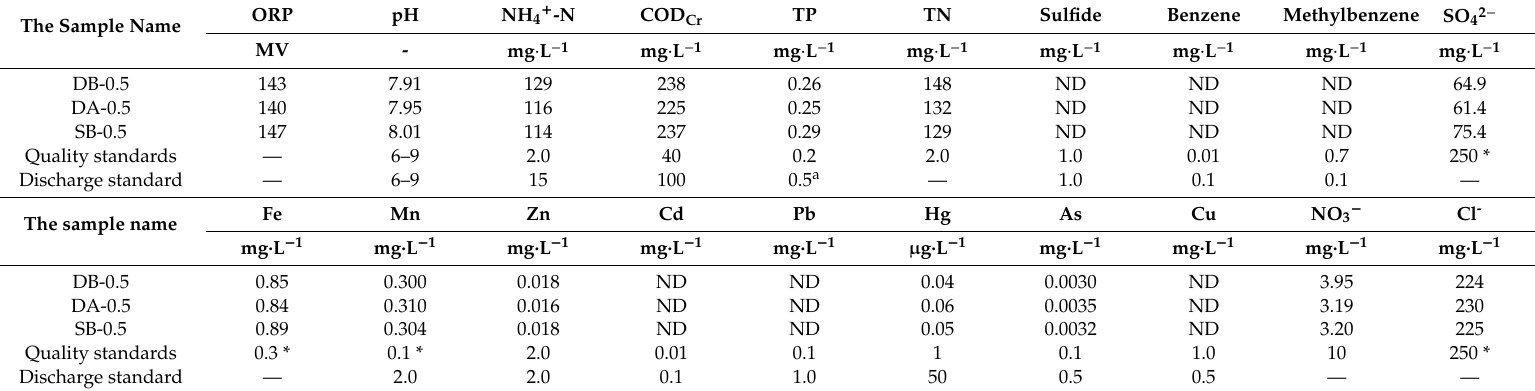
Table 4. Results of pollutant detection in water.